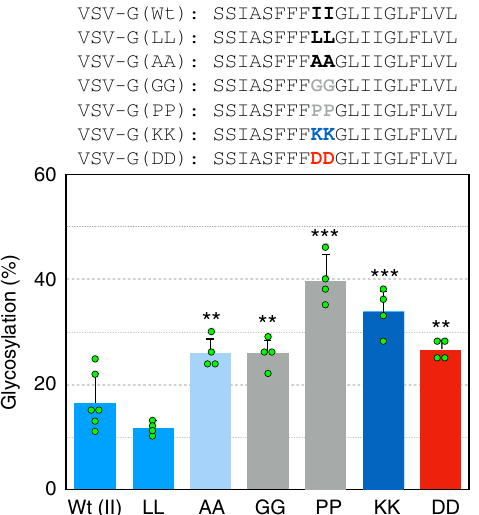
Fig. 4 Hydrophobicity and helicity affect TM folding. In vitro translation of truncated VSV-G constructs (distance P-NST of 67) in which the central Ile pair (shown in bold) was mutated to less hydrophobic, charged (basic and acid residues shown in dark blue and red, respectively) and helix breaking residues (shown in gray). The average glycosylation percentage is plotted for each mutant. Error bars show the standard deviation of four or more independent experiments ( p -values for the comparison with wild type (Ile pair): **<0.01 and ***<0.001). Individual data points are shown as green dots. Source data are provided as a Source Data fi difference in the glycosylation ef fi ciency for both distances, consistent with the adoption of α -helical structure in the ribosome tunnel of these test sequences. In fact, the observed glycosylation patterns (Supplementary Fig. 7) mirror those obtained for the VSV-G and gp41 containing constructs (Fig. 1b, top panels).